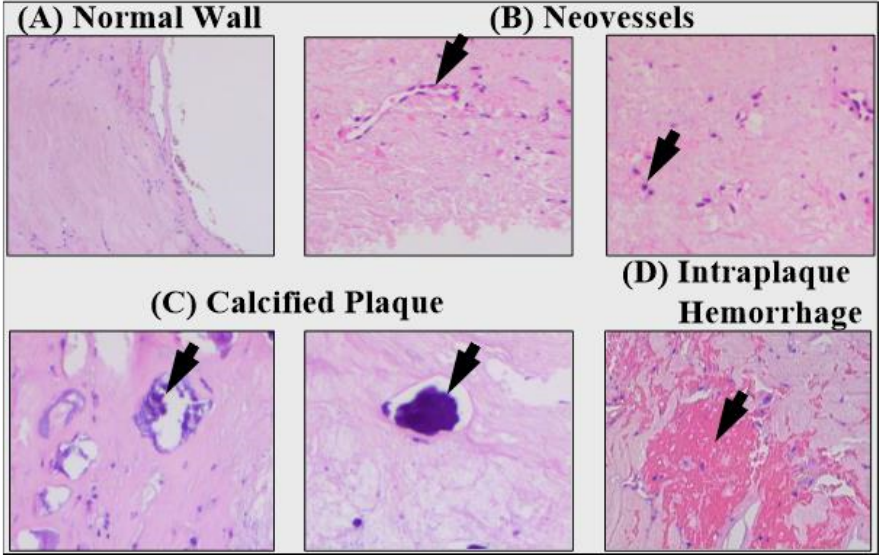
Figure 19. Different plaque components depicted in pathological pictures: ( A ) healthy wall, ( B ) neovessels, ( C ) calcified plaque, and ( D ) interplaque hemorrhage (courtesy of Dr. Luca Saba, U of Cagliari, Italy) [222].